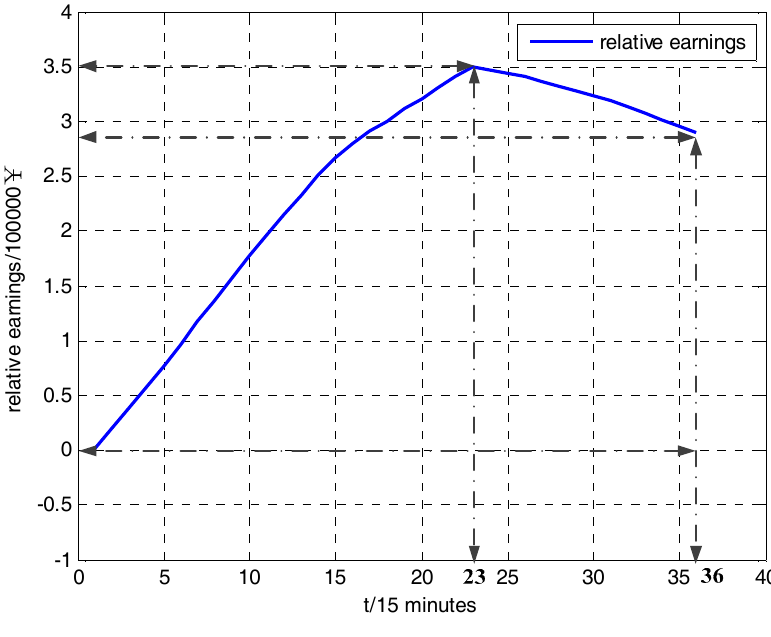
Figure 9. Diagram of the relative earnings of the next 9 h.